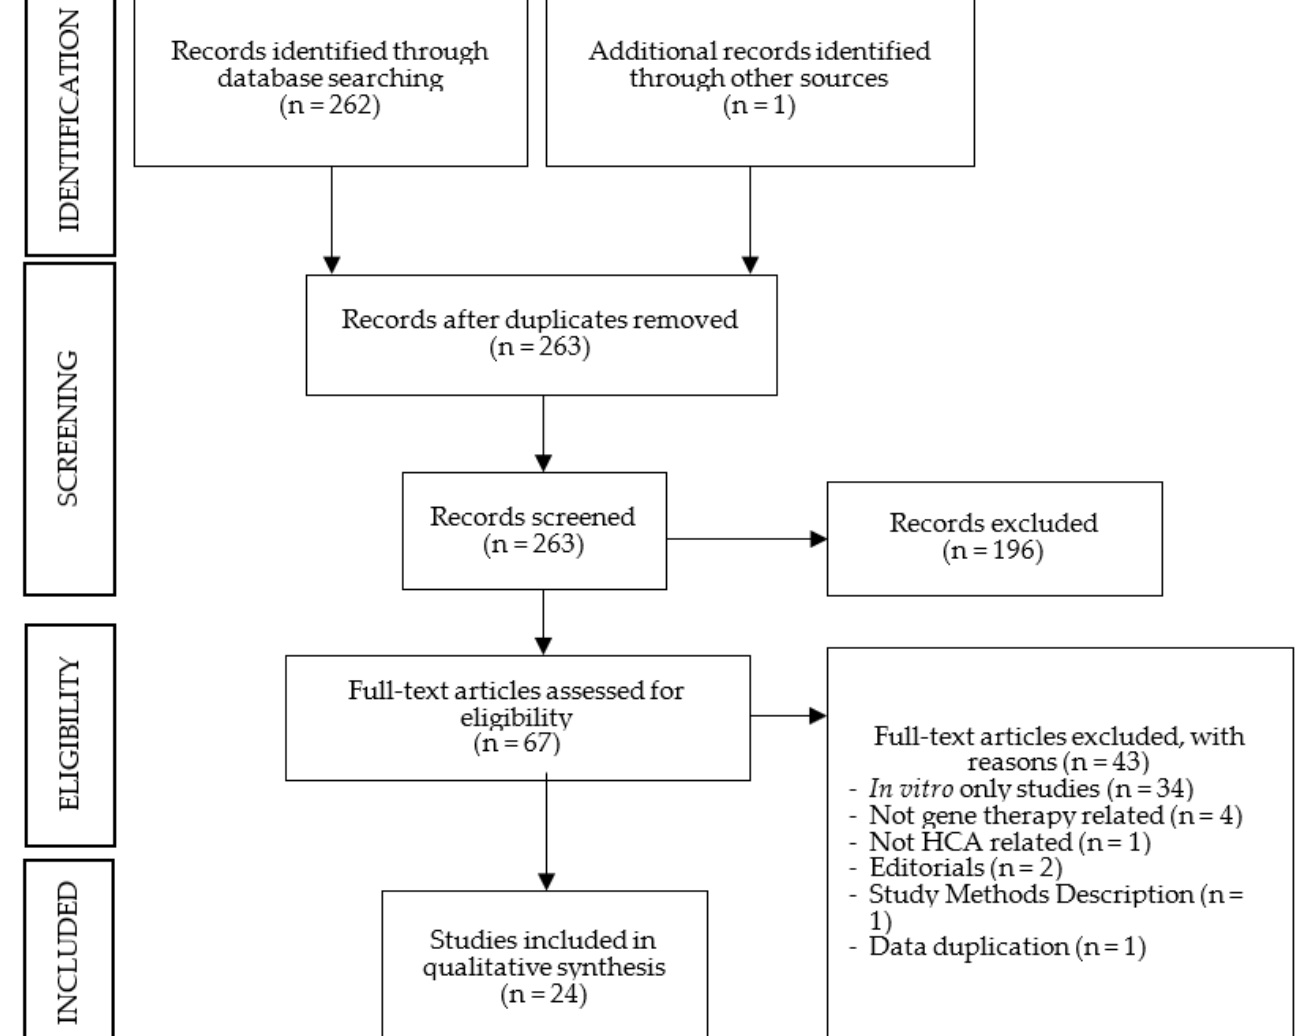
Figure 1. Search results in a fl ow diagram (adapted from PRISMA 2009).